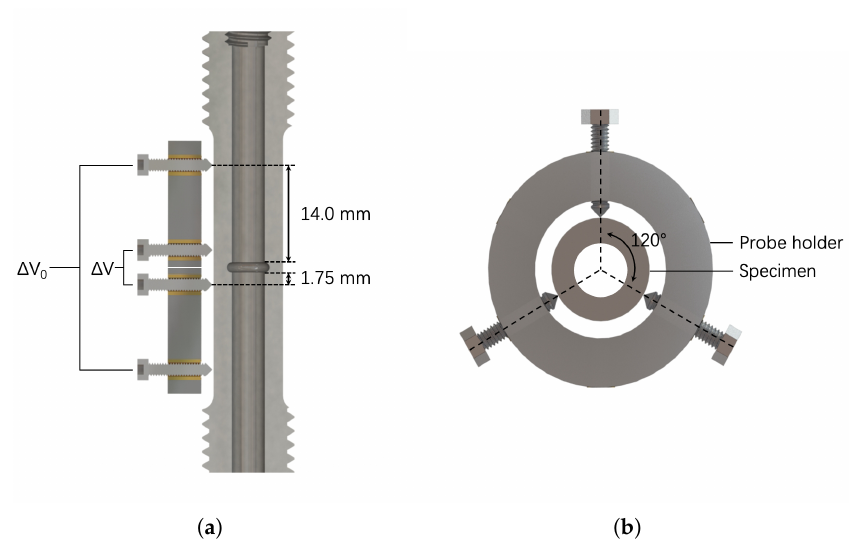
Figure 4. Illustration of the positions of the DCPD probes. ( a ) Cross-sectional view of the specimen and two stacked probe holders. The brass elements represent the internally threaded heat inserts. ∆ V ∆ V indicate the potential drop measurement locations of the reference probes over the 0 and gauge and the probes over the notch, respectively. The distance between the measurement location of these probes and the side of the notch are annotated. ( b ) Top cross-sectional view of the gauge of the specimen and the probe holder. The three probes are equidistantly arranged along the